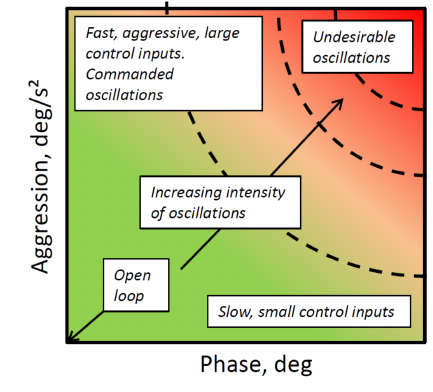
Figure 6. Schematic of phase-aggression criterion (PAC) detection algorithm.